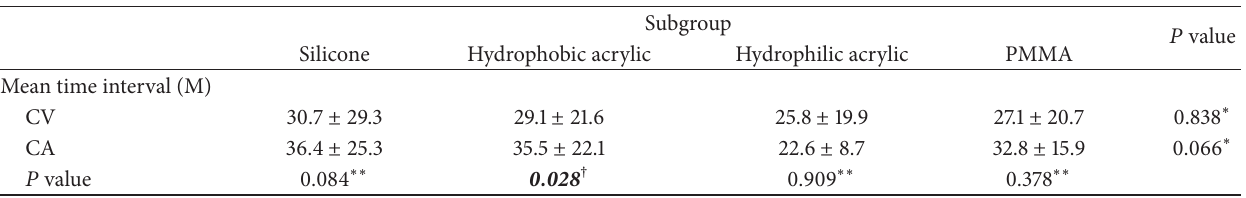
Table 4: Comparison of the mean time interval within the IOL subgroup in cataract surgery with or after vitrectomy and cataract surgery alone.